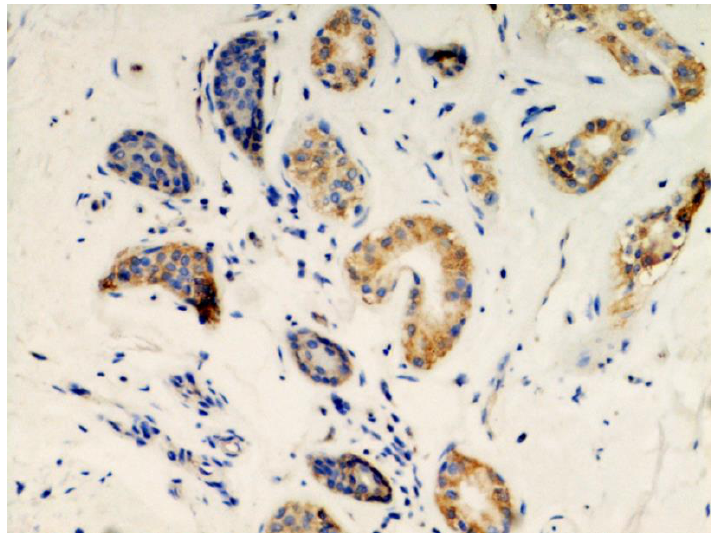
Figure 3. Immunohistochemical details of patients with COVID-19-linked maculopapular eruptions (original magnification, 400×).